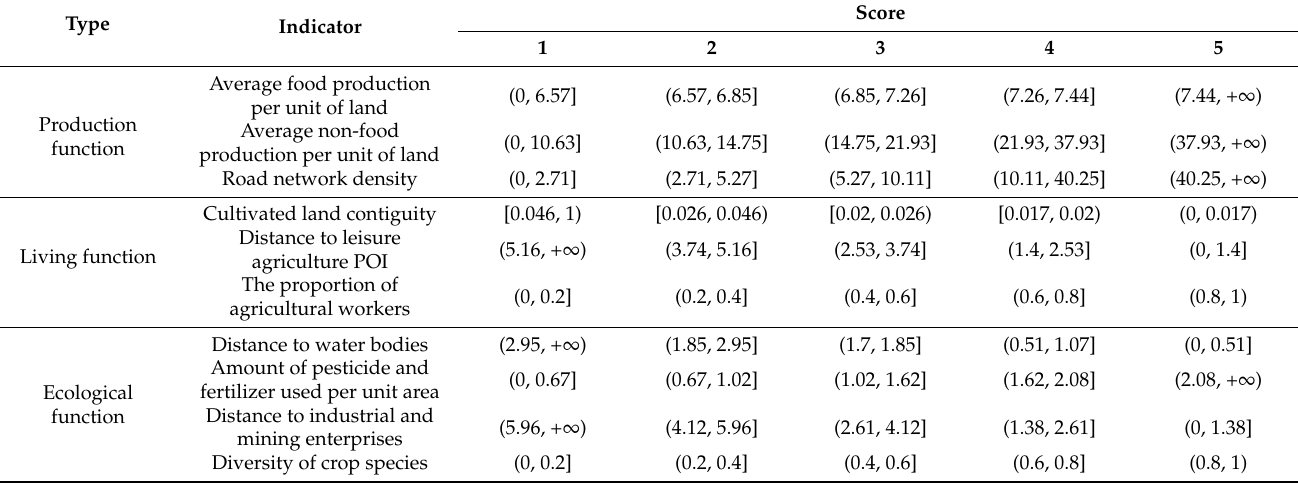
Table 3. Classification and assignment of CLUF evaluation indicators in Yuanyang